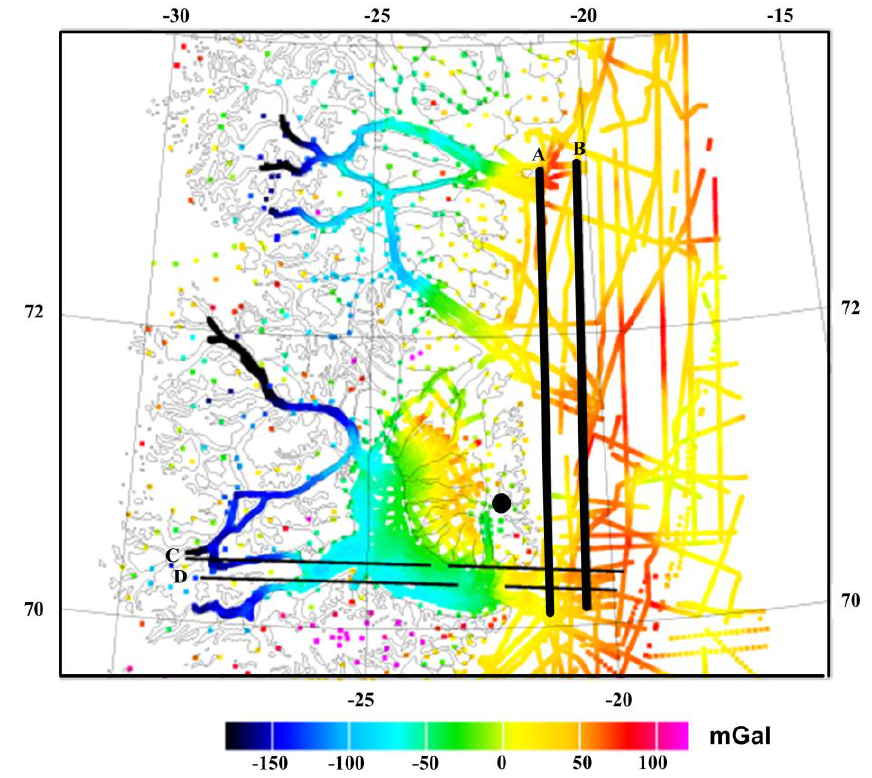
Figure 3. Flight profiles in the Greenland test and existing ground, marine and airborne coverage of the region [31]. The four flight profiles shown in black (the primary flight lines are in bold) were designed in central East Greenland. Breaks in lines C and D are due to altitude changes. Other light color lines denote the marine data. The black dot represents the GPS base station and the colors show the free-air